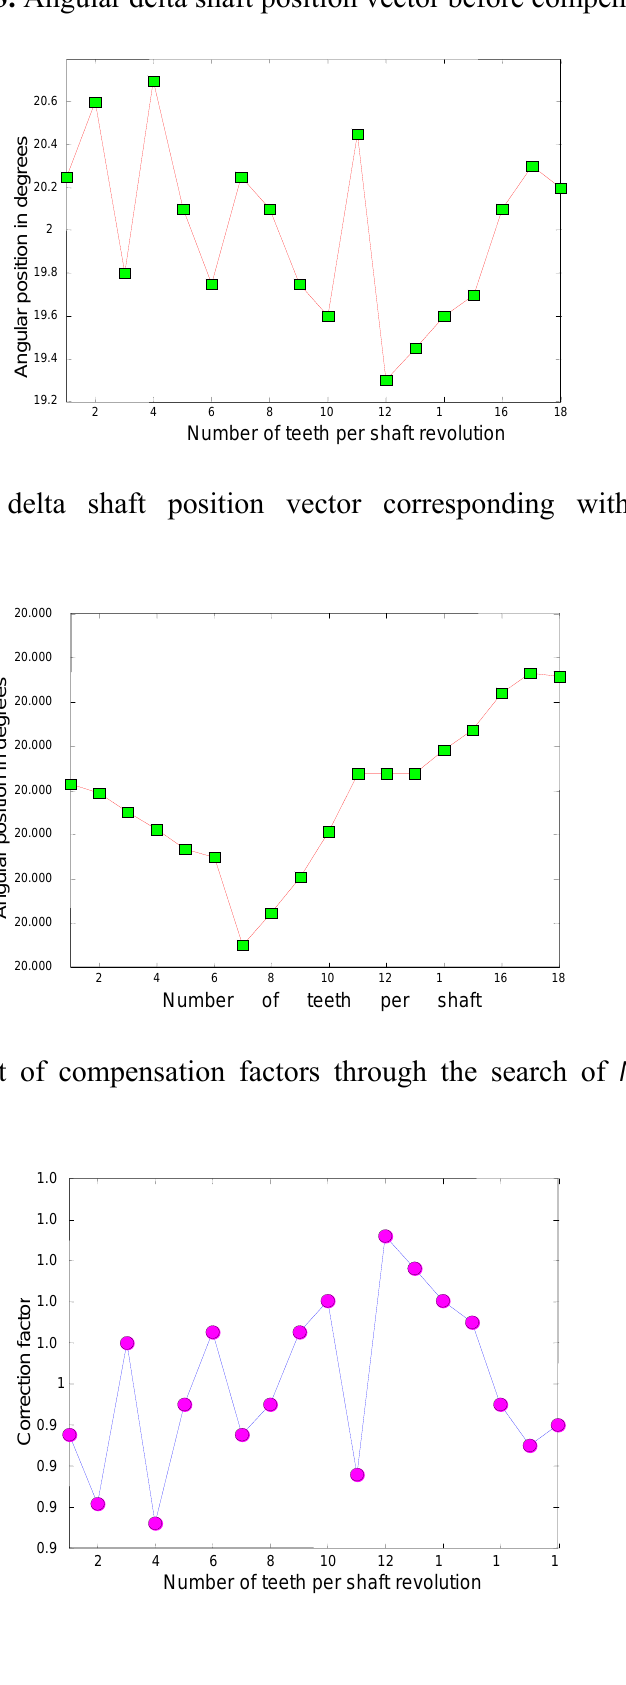
Figure 3. Angular delta shaft position vector before compensation.